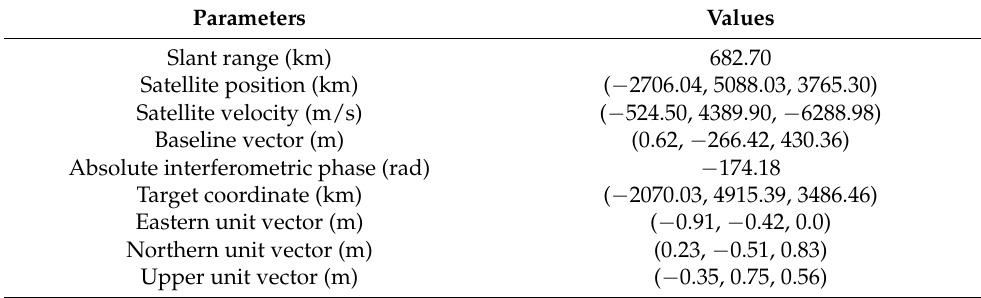
Table 1. The parameters used for sensitivity